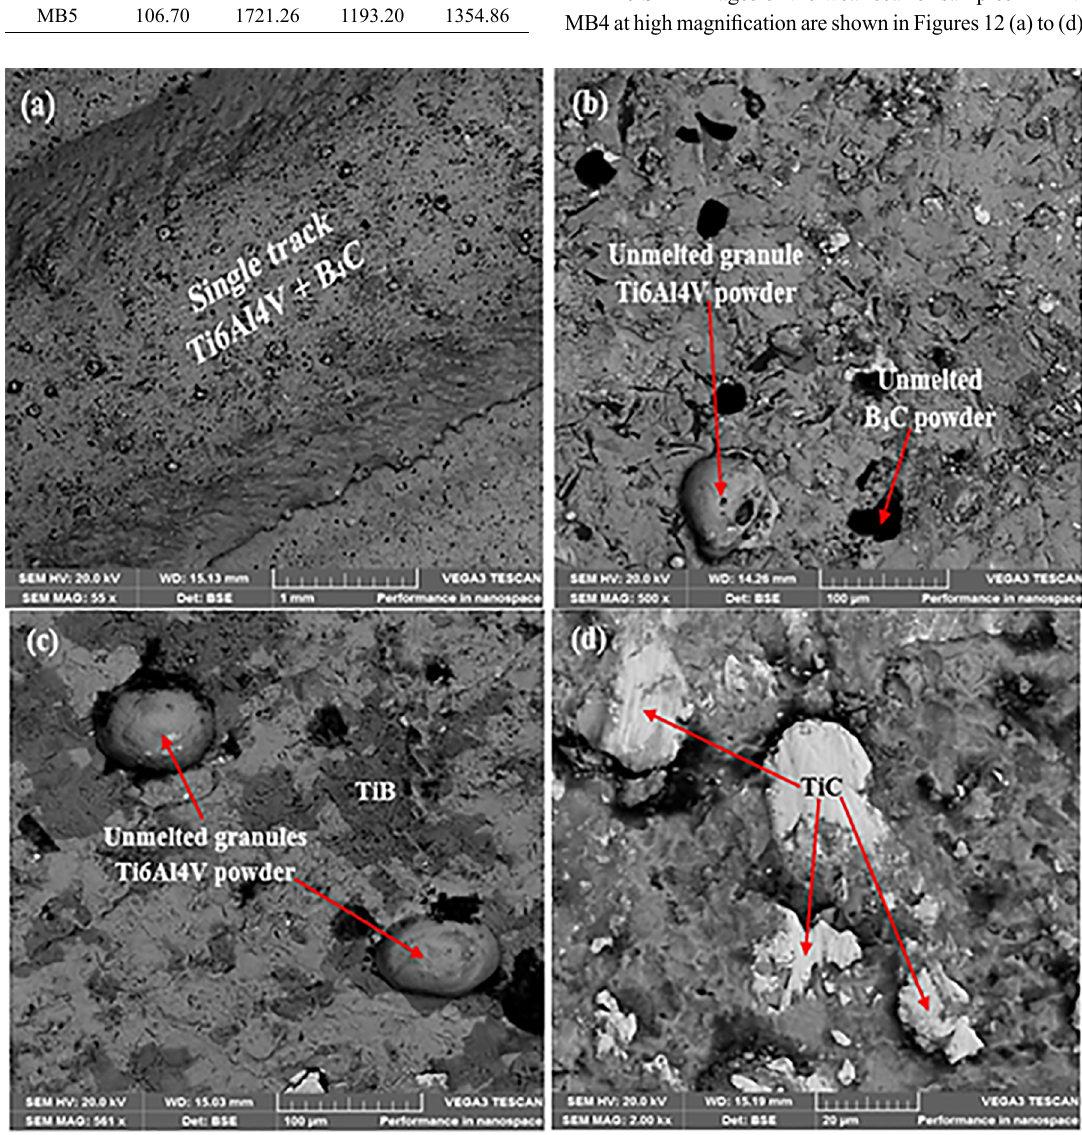
Figure 12. SEM images of the wear track of sample MB1 to MB4.